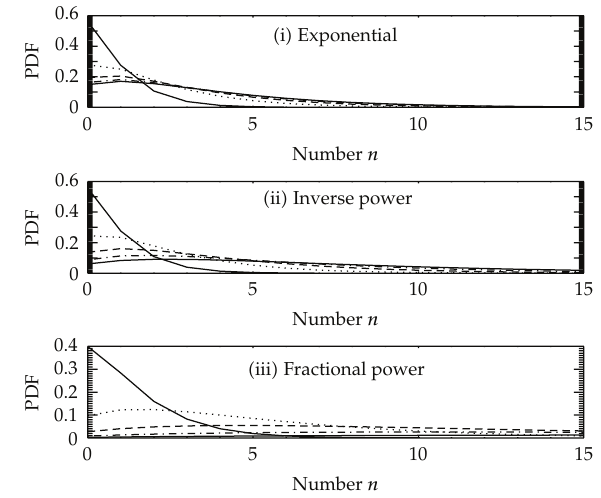
Figure 4: Time dependence of p (cid:3) n,t (cid:4) in (cid:3) 3.15 (cid:4) for three relaxation functions for κ (cid:3) t (cid:4) in Table 2: (cid:3) i (cid:4) an exponential function, and (cid:3) ii (cid:4) an inverse power function, (cid:3) iii (cid:4) a fractional power function; the values of parameters are α (cid:7) 1, κ (cid:7) 1, and γ (cid:7) 0 . 85. The pdf profiles are depicted for t (cid:7) 0 . 4 (cid:3) solid line (cid:4) , t (cid:7) 1 . 2 (cid:3) dotted line (cid:4) , t (cid:7) 2 . 0 (cid:3) dashed line (cid:4) , t (cid:7) 2 . 8 (cid:3) dash-dotted line (cid:4) and t (cid:7) 3 . 6 (cid:3) dash-dotted line (cid:4) .